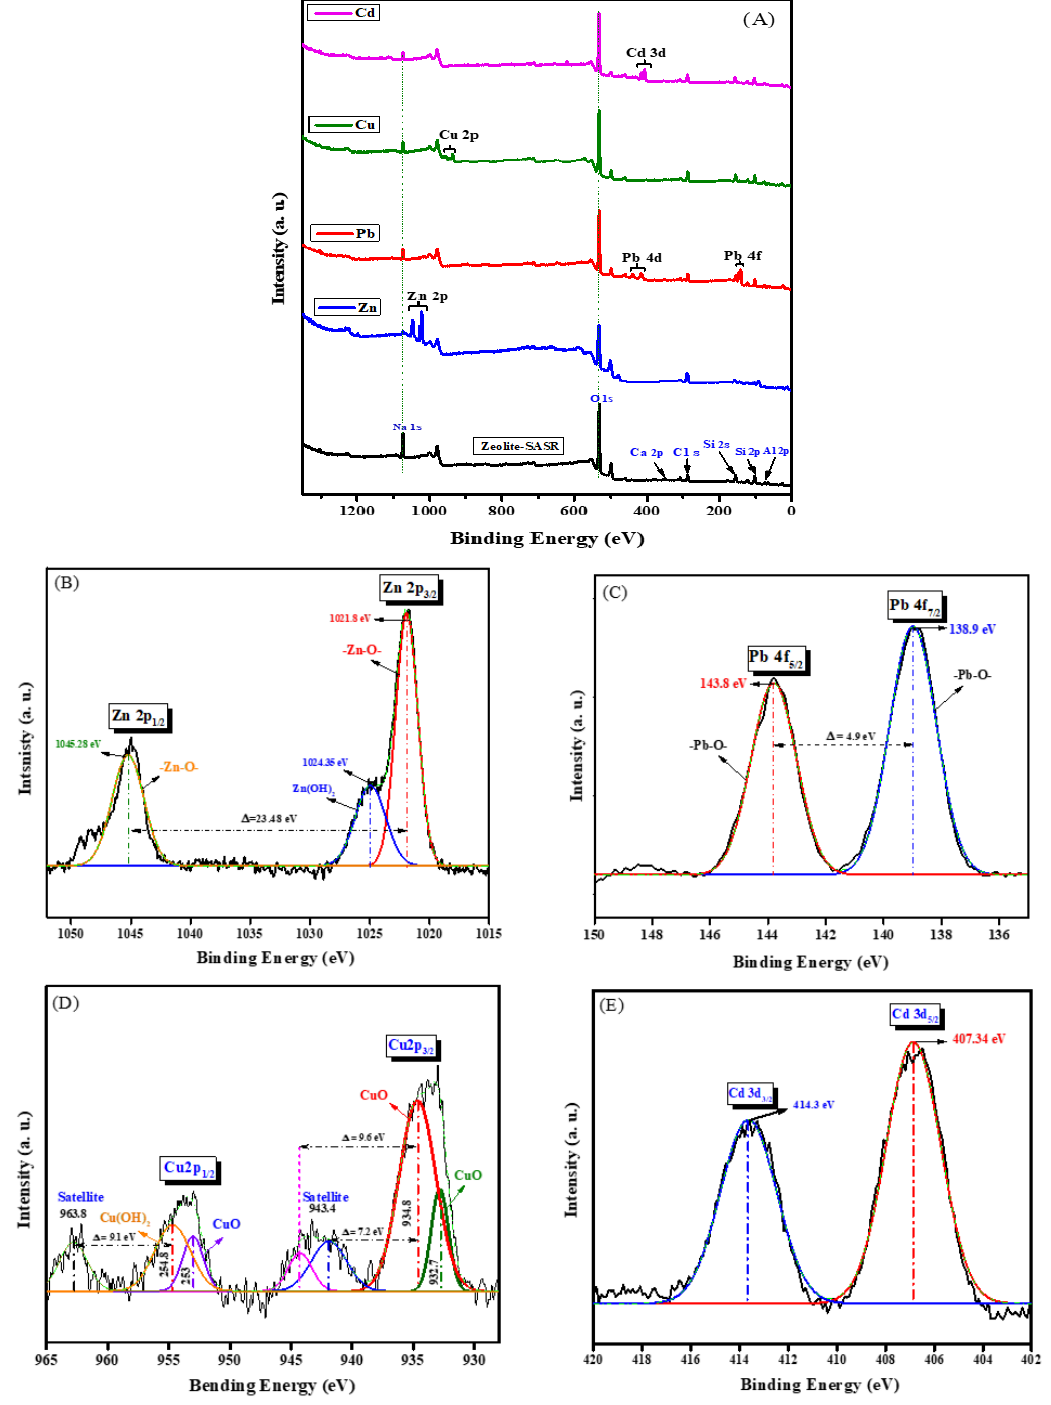
Figure 12. XPS wide scan of synthesized zeolite before and after Zn, Pb, Cu, and Cd adsorption: Full range ( A ), High-resolution XPS spectra of Zn2p ( B ), Pb4f ( C ), Cu2P ( D ), and Cd3d ( E ).